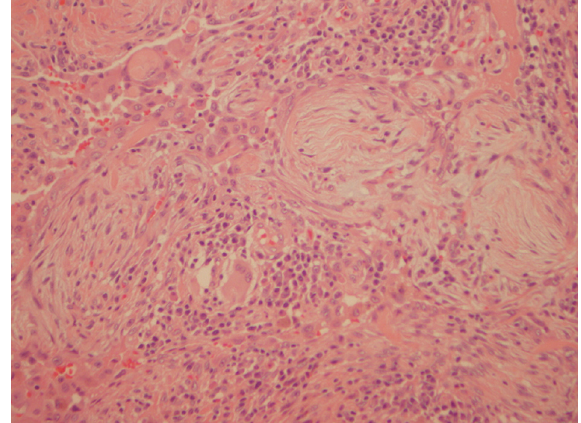
Figure 4: Left lung biopsy of patient two showed subpleural proliferative fibroblastic foci and a nodular infiltrate of plasma cells, histiocytes, and multinucleated giant